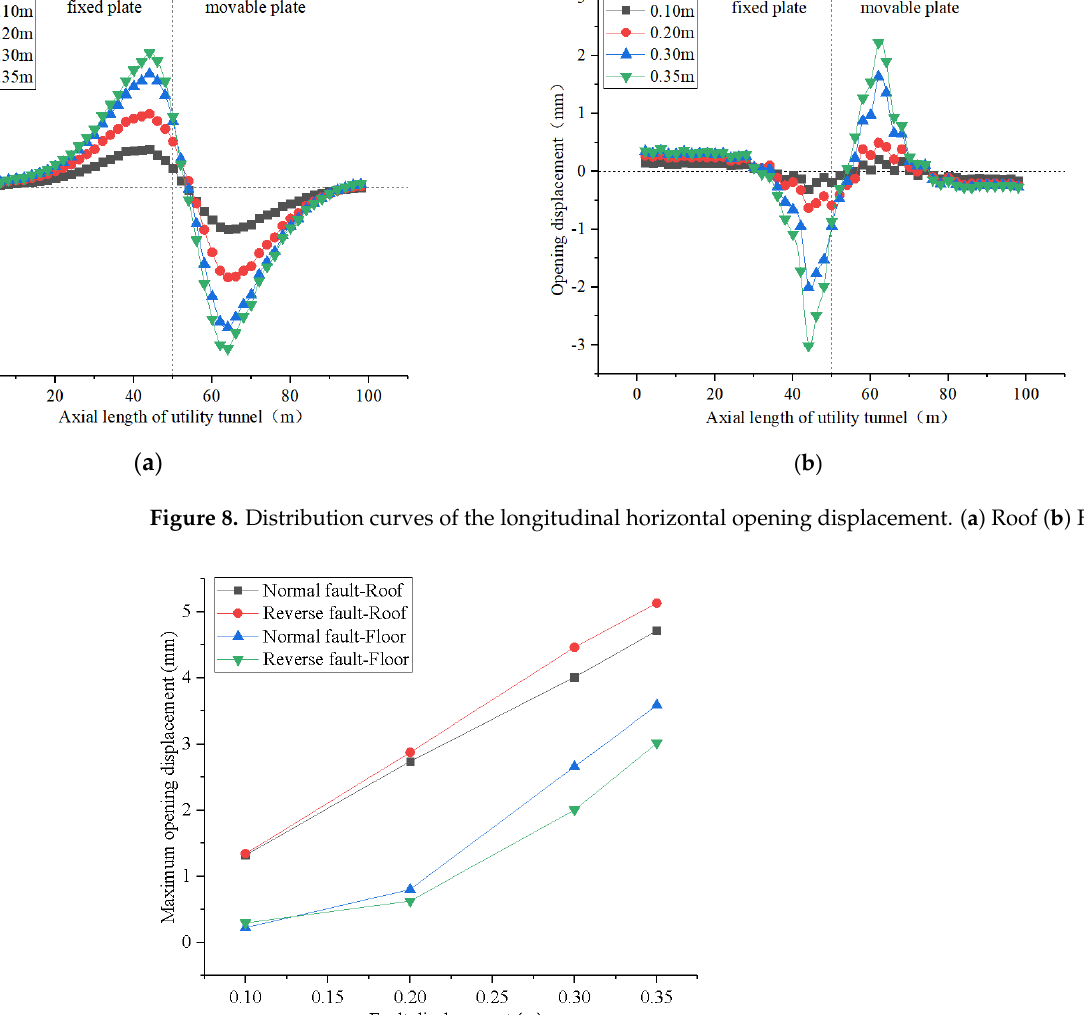
Figure 9. Relationship between the maximum opening displacement and fault displacement.